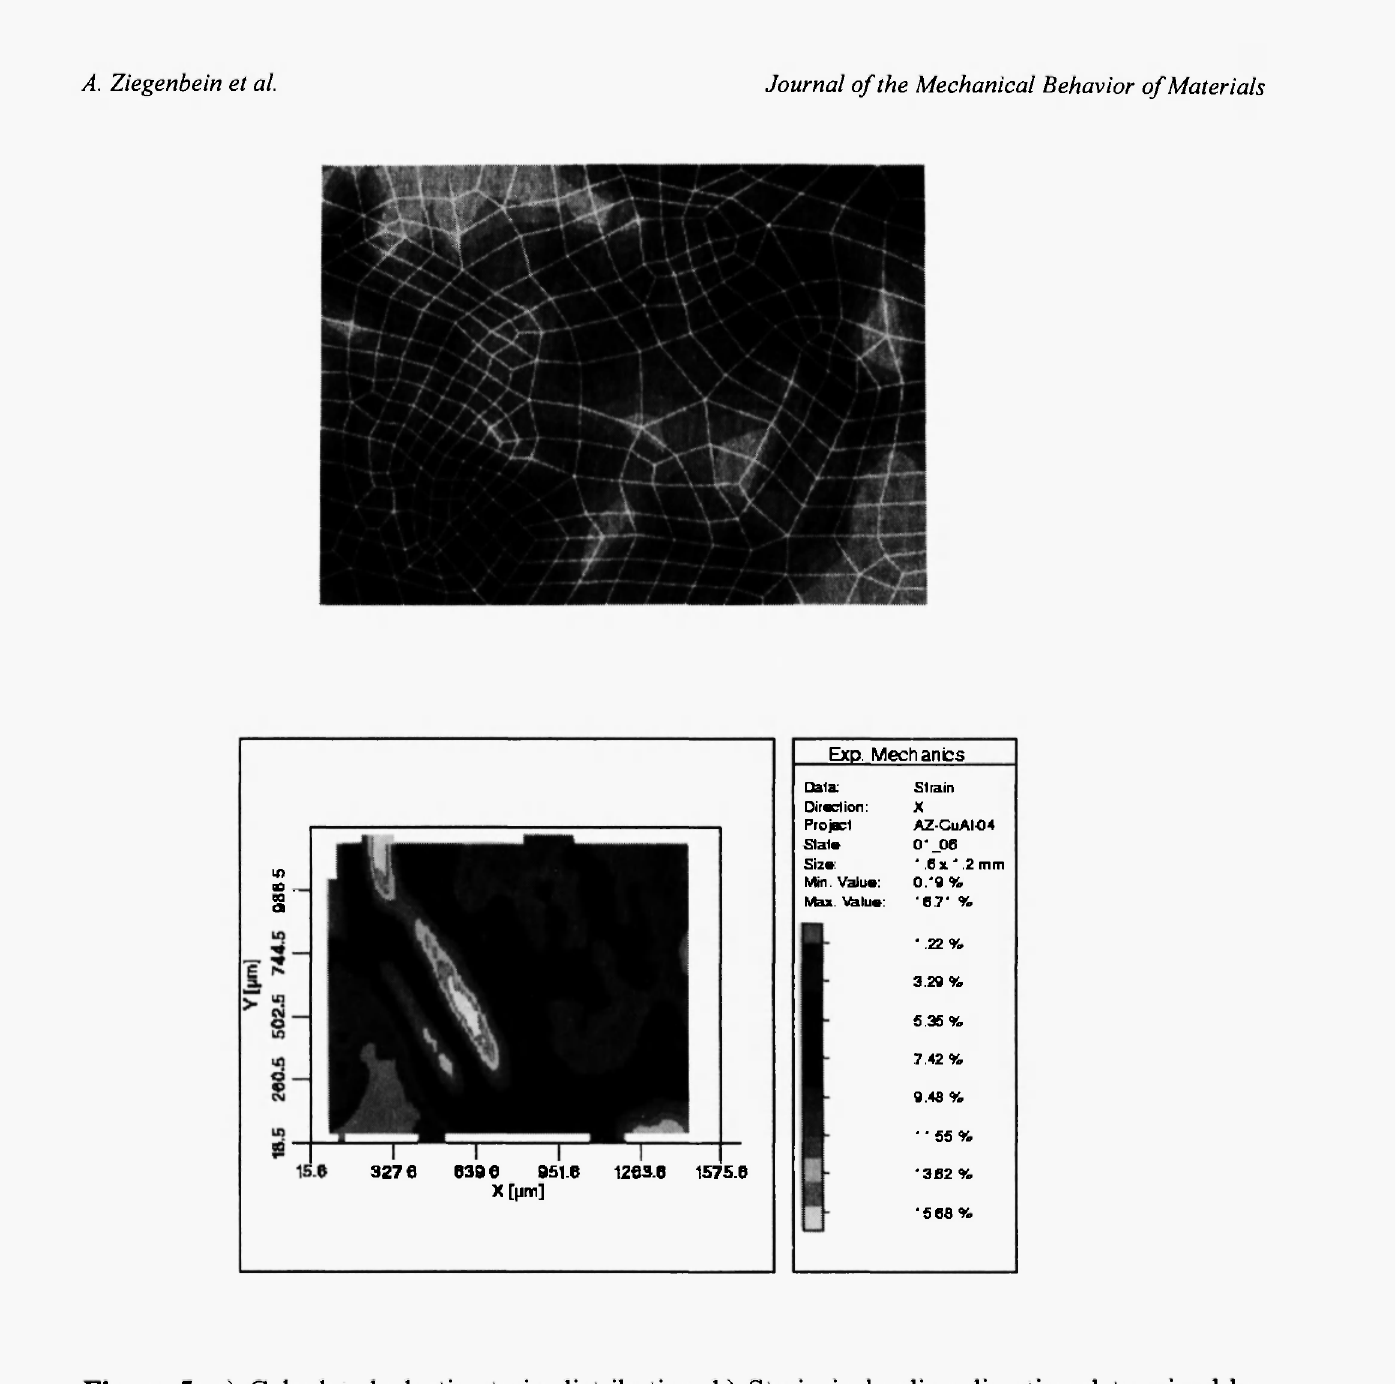
Figure 5: a) Calculated plastic strain distribution, b) Strain in loading direction determined by optical whole field deformation measurement (same area as